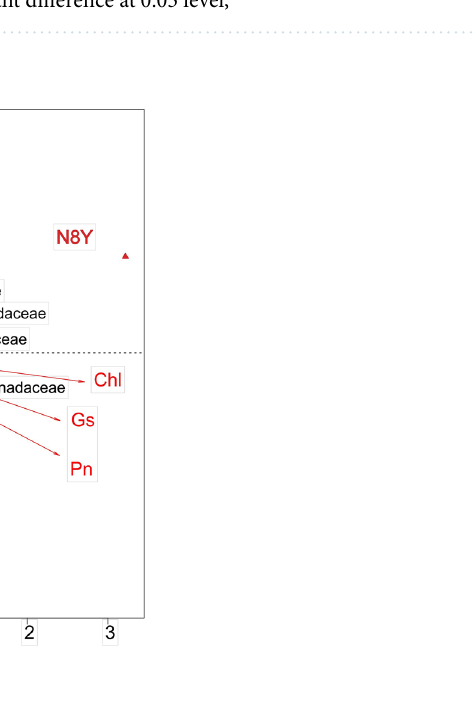
Table 4. Comparison of photosynthetic parameters of sorghum populations under different nitrogen application conditions. *Indicates significant difference at 0.05 level, ** indicates significant difference at 0.01 level, lowercase English letters indicates significant difference at 0.05 level,